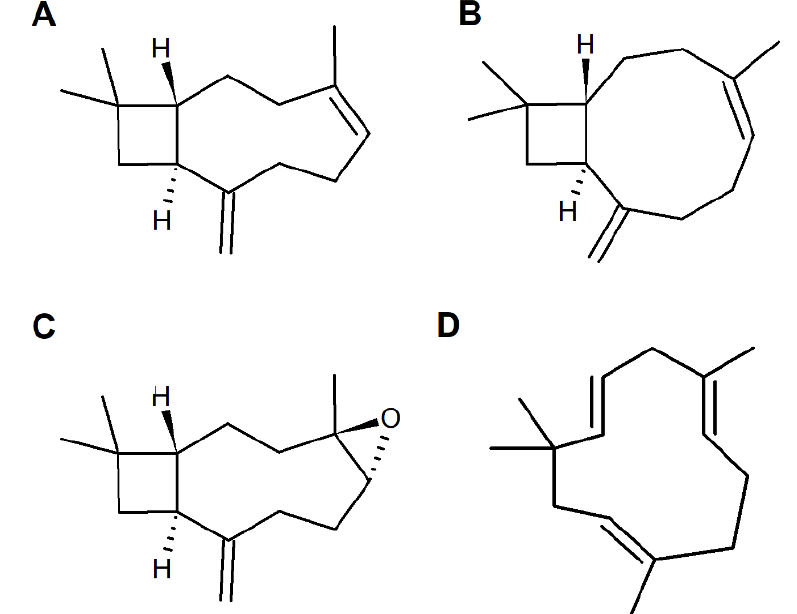
Figure 3. Chemical structures of widely occurring caryophyllane sesquiterpenes in plants. ( A ) β- Caryophyllene; ( B ) Isocaryophyllene or γ-caryophyllene; ( C ) β-Caryophyllene oxide or 4β,5α- epoxycaryophyll-8(13)-ene; ( D ) α-Humulene or